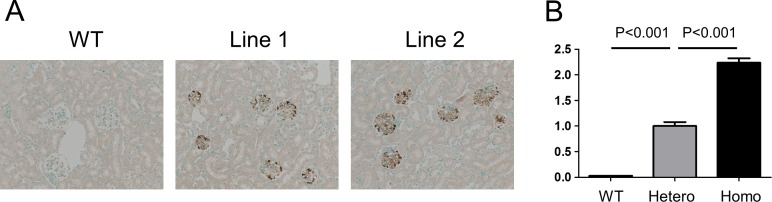
EGFP expression and genotyping of Nephrin-EGFP mice.(A) EGFP protein was expressed preferentially at periphery of glomeruli in two lines of Nephrin-EGFP mice by immunohistochemistry using anti-GFP antibody. (B) Genotyping of wild-type (WT), heterozygous (Hetero) and homozygous (Homo) mice by genomic qPCR. Amount of EGFP genomic DNA detected in WT mice was less than 1% of heterozygous mice. Mean±SEM of n = 4–8. Comparison was carried out by unpaired t test. Magnification, 10x.